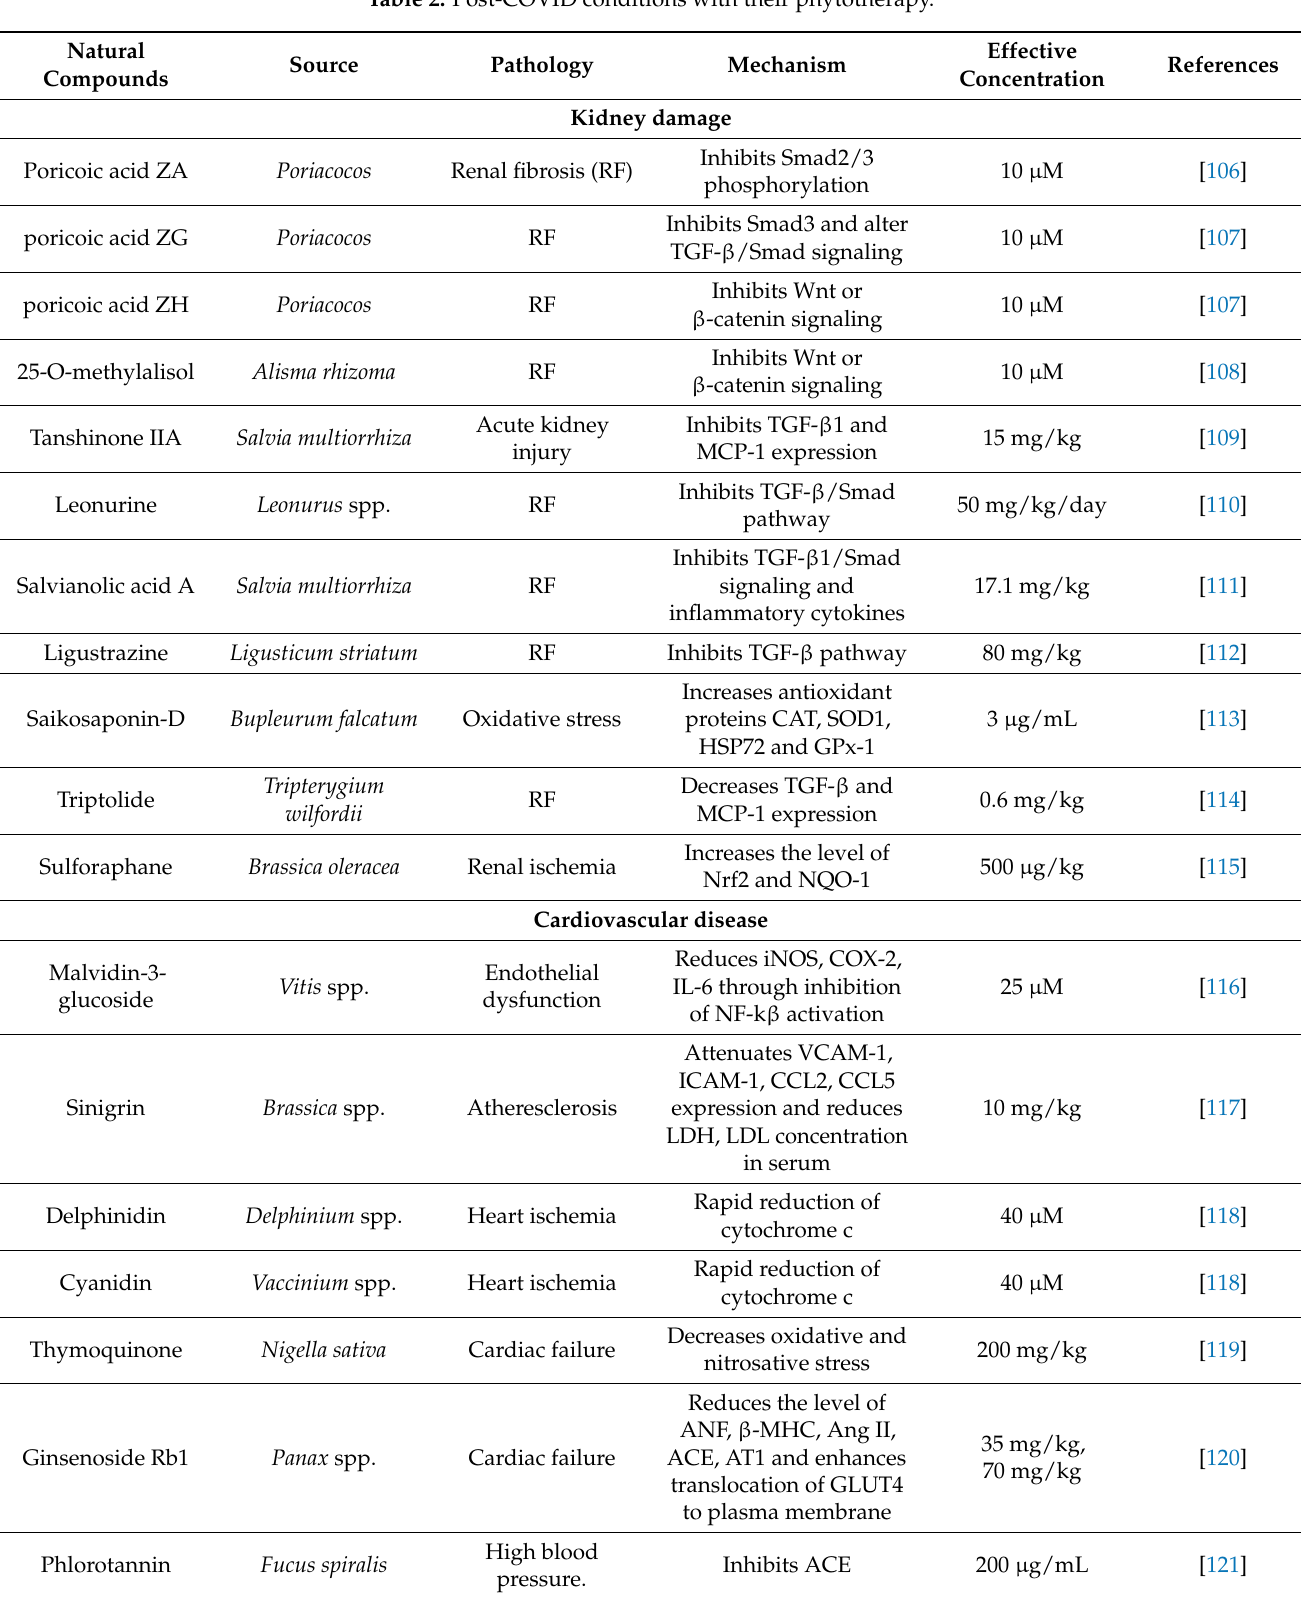
Table 2. Post-COVID conditions with their